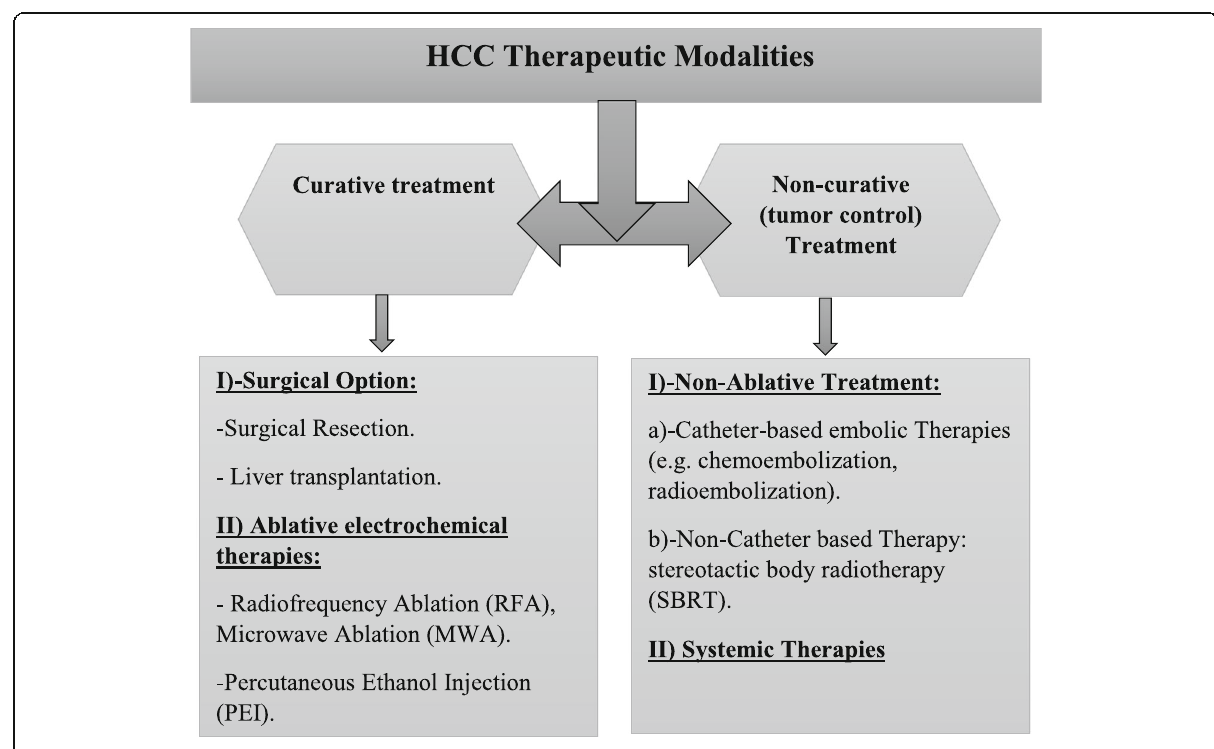
Fig. 1 Therapeutic modalities used for HCC treatment